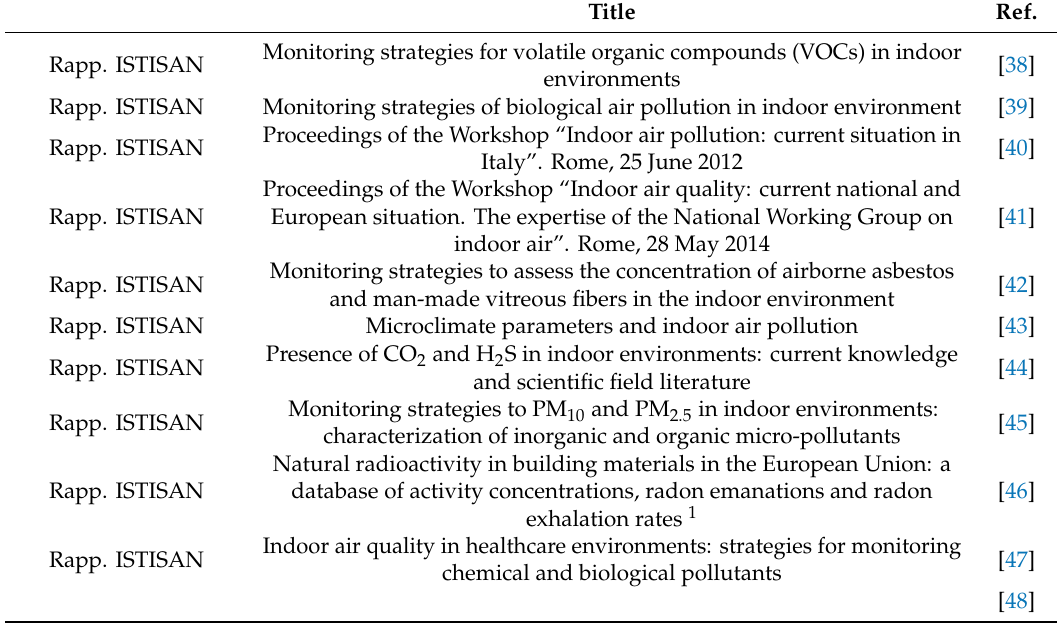
Table 3. Rapporti ISTISAN just published by the National Study Group (GdS) on Indoor Pollution. Title